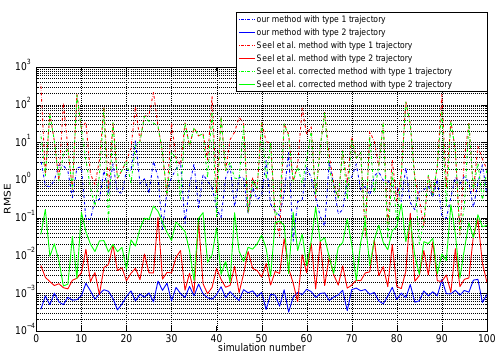
Figure 5: RMSE for 100 different IMU to body configurations when using the measurement model defined in (13) and the ad- ditional constraint in